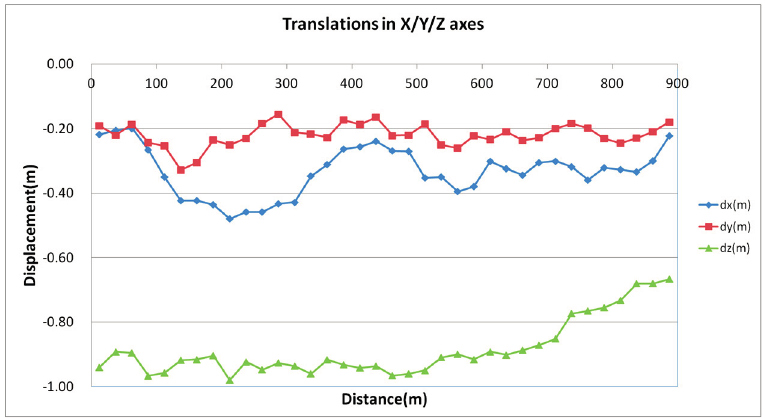
Figure 12. The translations in X/Y/Z directions (ALS/MLS registration).